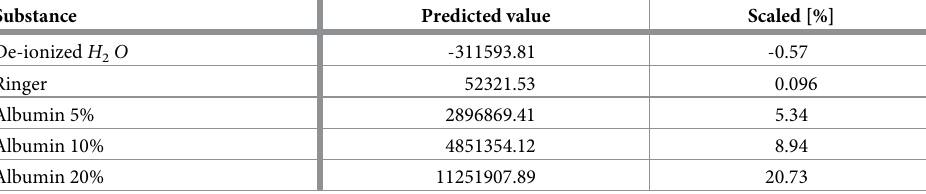
Table 3. Validating the predictive model with well-defined concentrations of albumin. The predicted value is a lin- ear combination using nine frequencies from the respective spectrum. Both de-ionized water and Ringer solution have an albumin concentration of